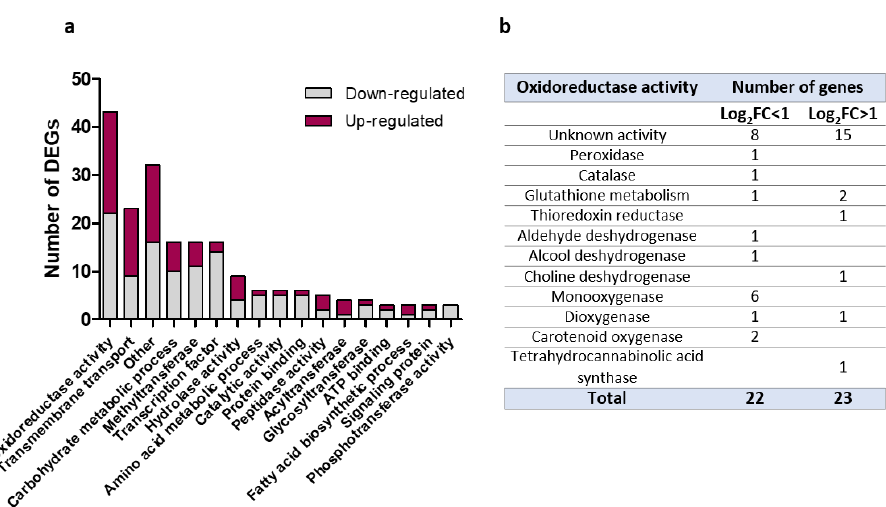
Figure 9. Functions of differentially expressed genes (DEGs) in M1 relative to ∆ KU70 . ( a ) Distribution of functions or metabolic pathways in DEGs with a known function (N = 198). The 80 DEGs